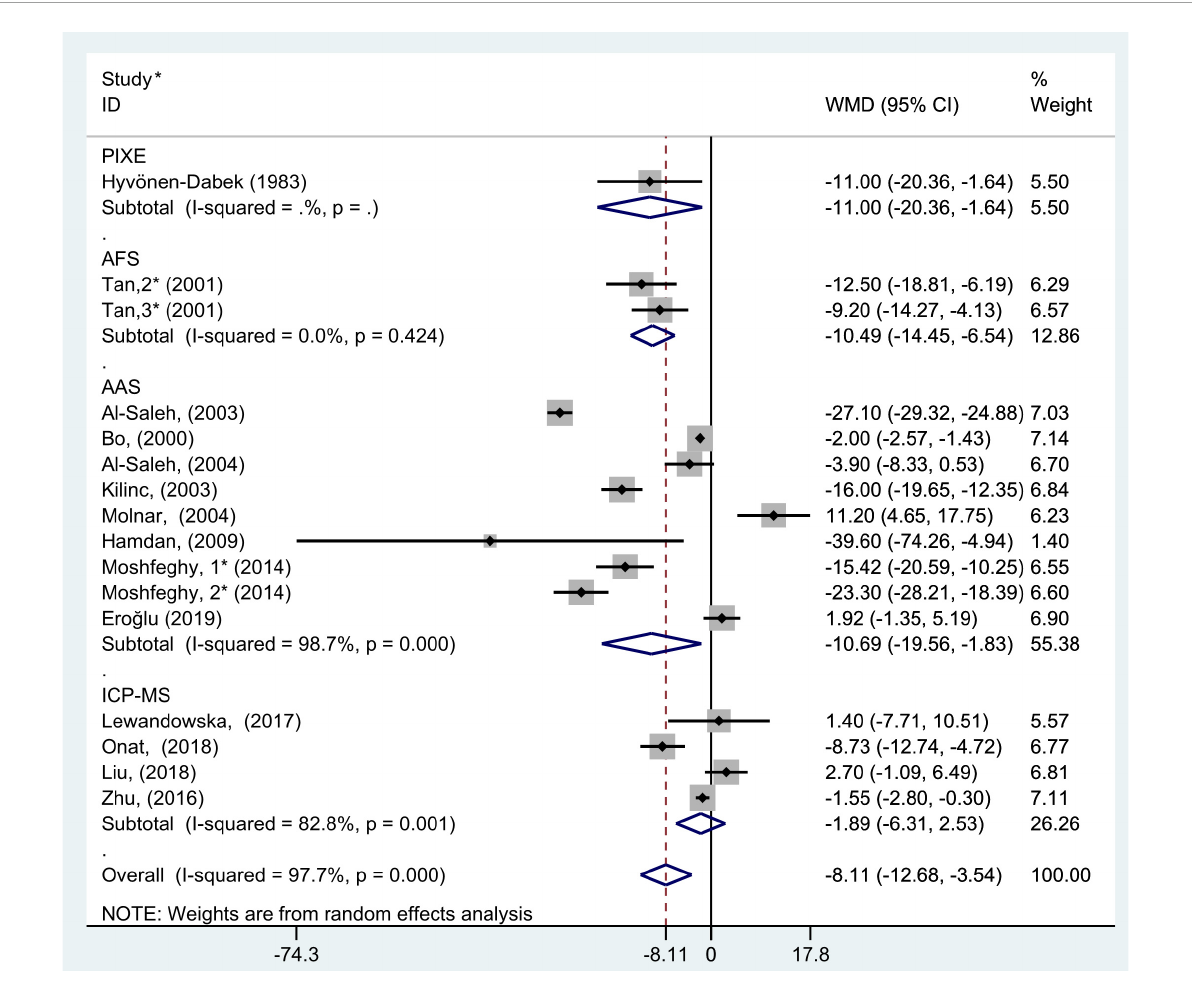
FIGURE8 Subgroup analysis of blood selenium level in patients with gestational diabetes mellitus and healthy pregnant women based on blood selenium measurement methods. The random effect model is applied. PIXE, proton-induced x-ray emission; AFS, atomic fluorescence spectrometric; AAS, atomic absorption spectrometry; ICP-MS, inductively coupled plasma mass spectrometry. For studies in which blood selenium levels were measured during different pregnancy periods in one study, 1, 2, and 3 are used to denote measurements performed in the first, second, and third trimesters, respectively. *First author (year of study